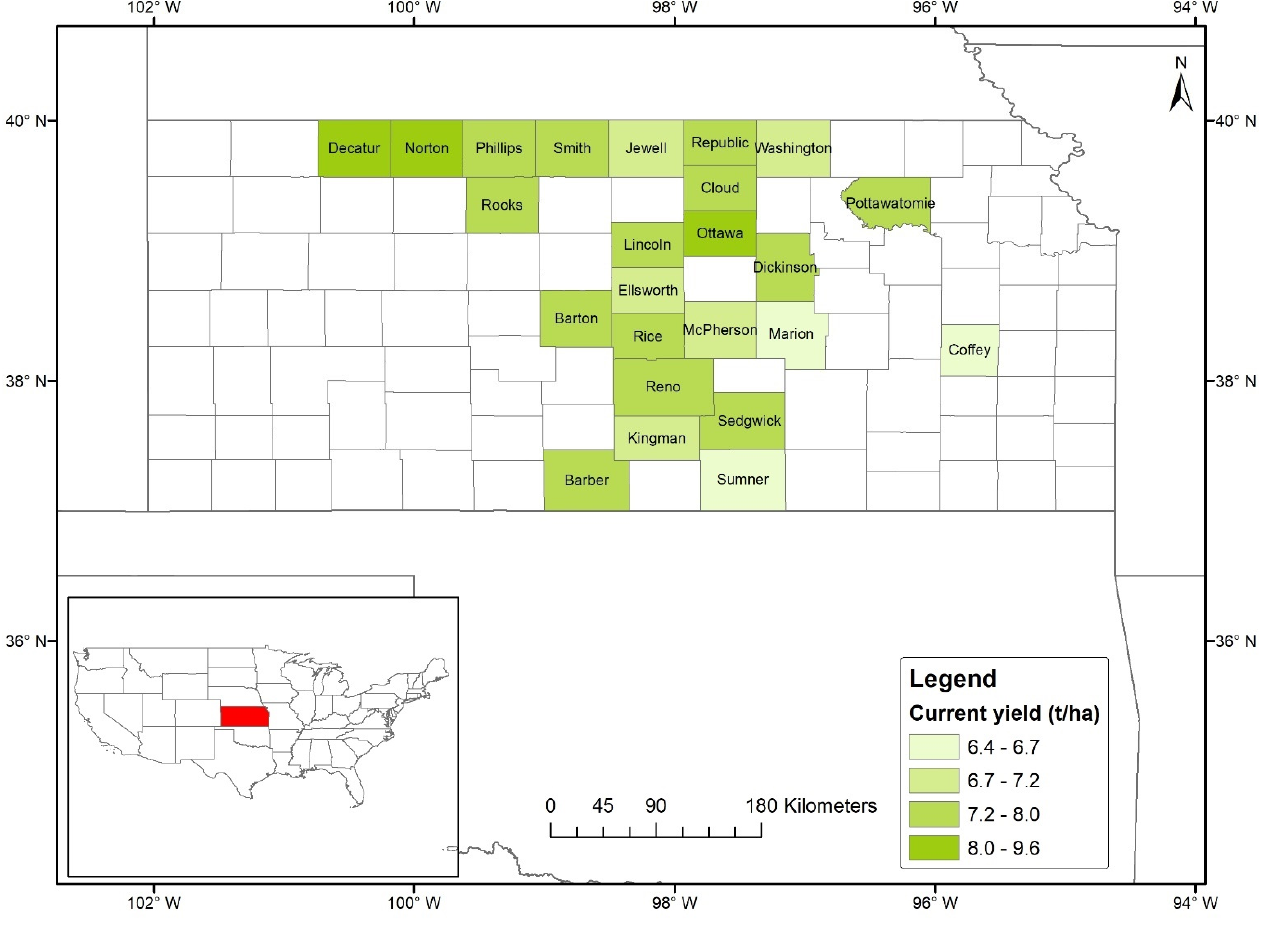
Figure 1. Map of Kansas showing selected rainfed counties ( n = 24) for this study. The green color represents current yield and the intensity of color represents yield variation in those counties.